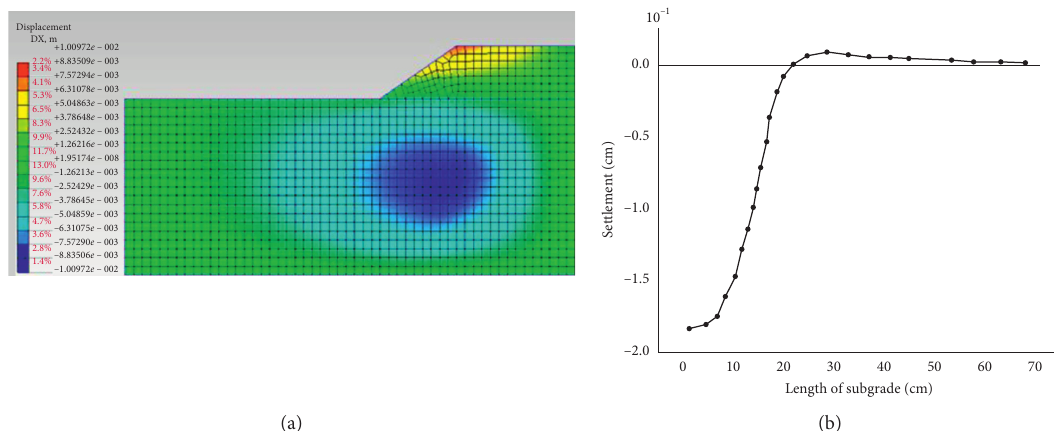
Figure 10: FLAC-2D numerical analysis results. (a) Foundation settlement curve. (b) Foundation settlement cloud